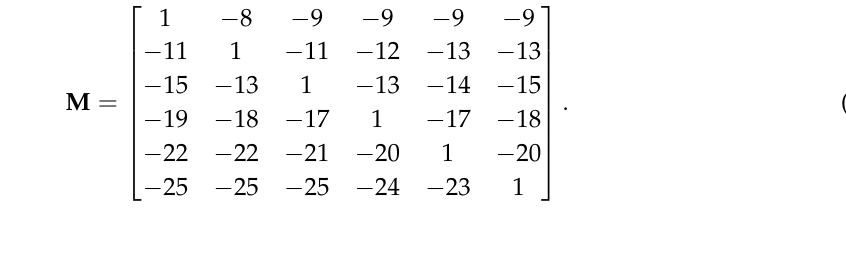
Table 2. Examples for sensitivity and time on air for a 125kHz bandwidth, coding rate 4/5, 20byte payload and 8symbols at